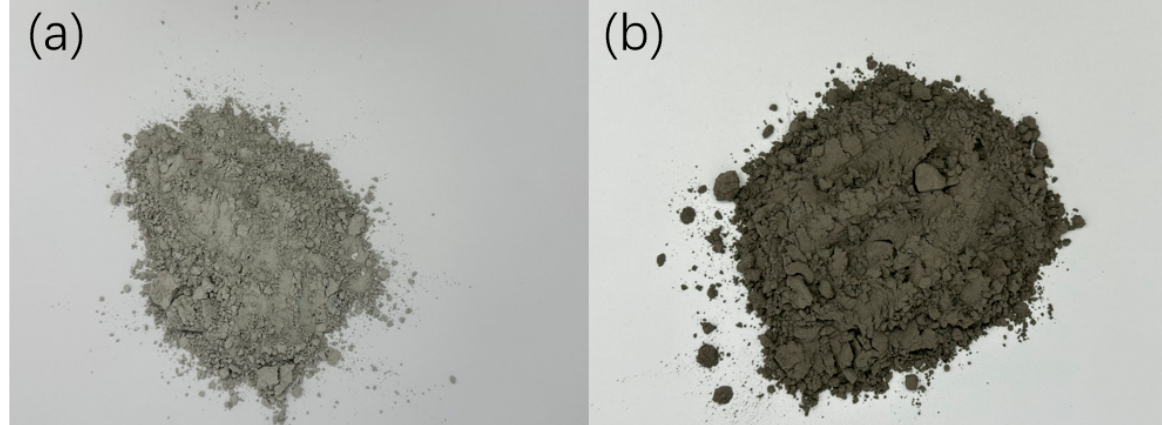
Table 1. The chemical composition of phosphogypsum and steel slag powder.